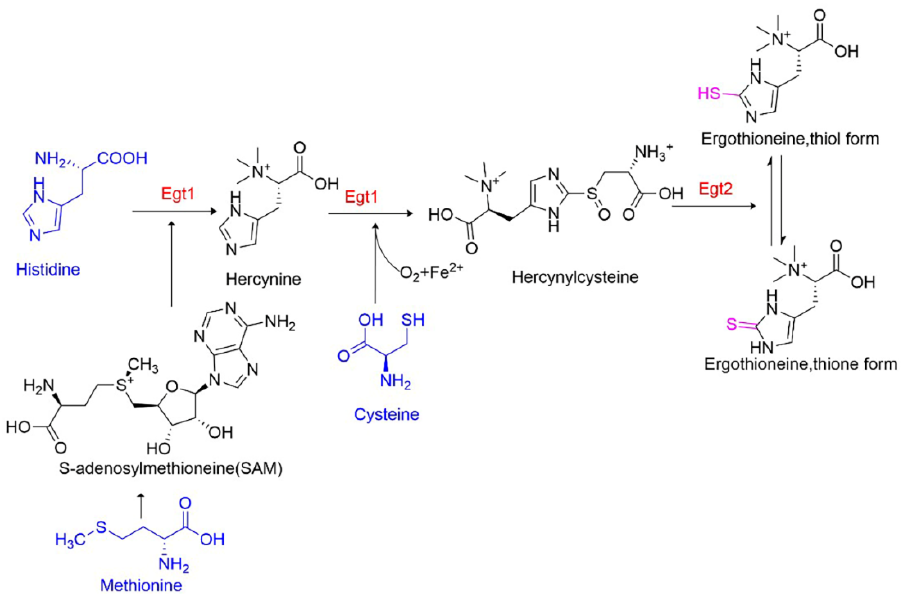
Figure 1. The fungal aerobic synthesis pathway of ergothioneine.